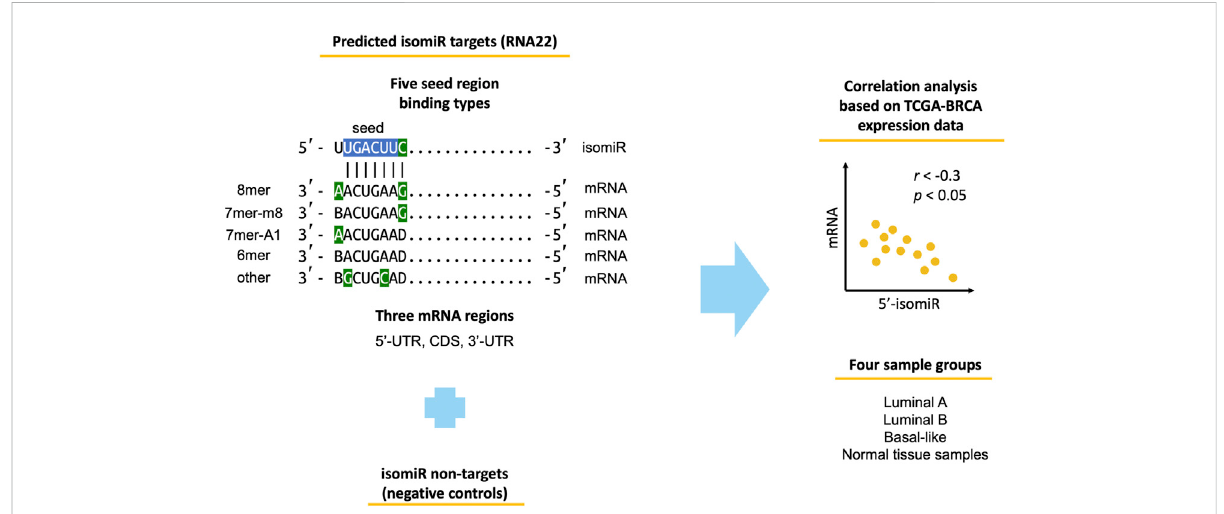
FIGURE 1 Work fl ow of theconducted analysis. Blue-colorednucleotides stand for the classical miRNA seed region. Green-colored nucleotidesstand for seed-type-speci fi c features (complementarity of nucleotide 8 for 8mer and 7mer-m8, adenine in position one for 8mer and 7mer-A1, G:U wobble and C:U mismatch for other). B stands for any nucleotide except adenine, D — any nucleotide except